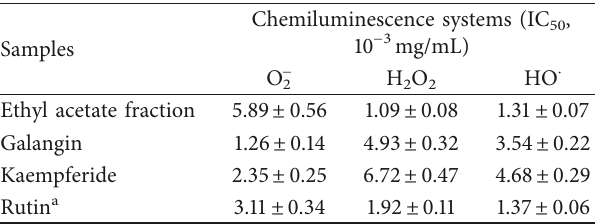
Table 2: Antioxidant activities of ethyl acetate fraction and target- separated antioxidants on different luminol CL systems.